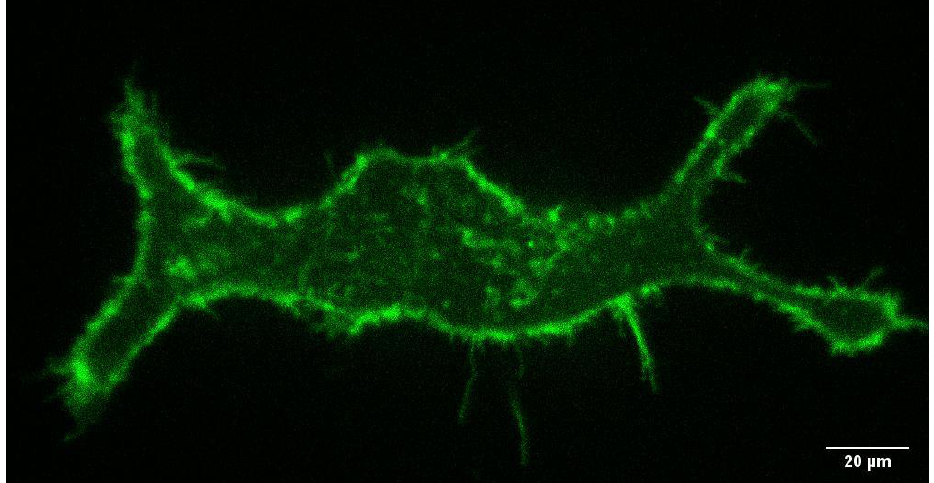
Figure 1. Representative TIRF-image of an untreated HEK-293 cell expessing GFP-AQP9